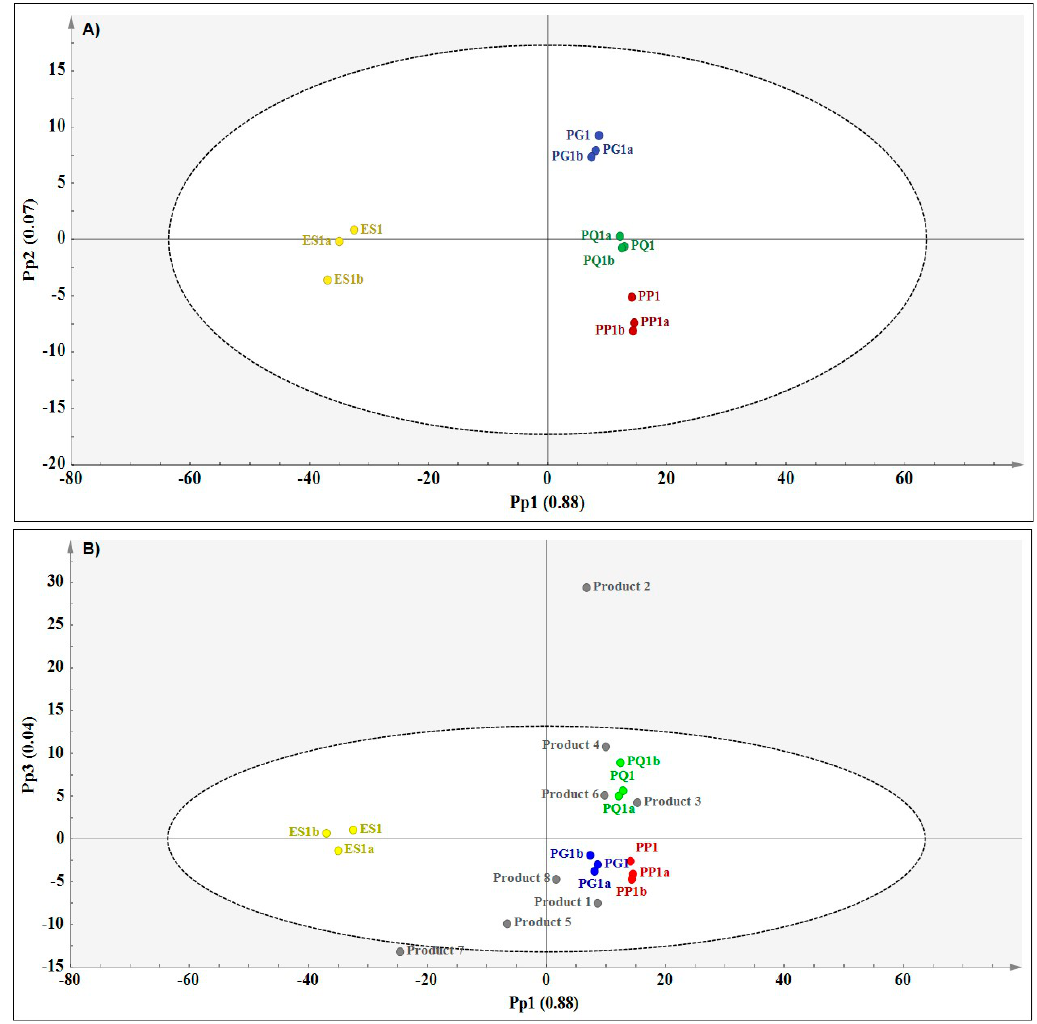
Figure 5. ( A ) OPLS-DA score plot (Pp1 vs. Pp2) showing species separation (PG— P. ginseng (blue); PQ— P. quinquefolius (green); PP— P. pseudoginseng (red) and ES— E. senticosus (yellow) and ( B ) prediction plot (Pp1 vs. Pp2) showing the relationships between the authentic reference materials and the commercial products based on MIR data.